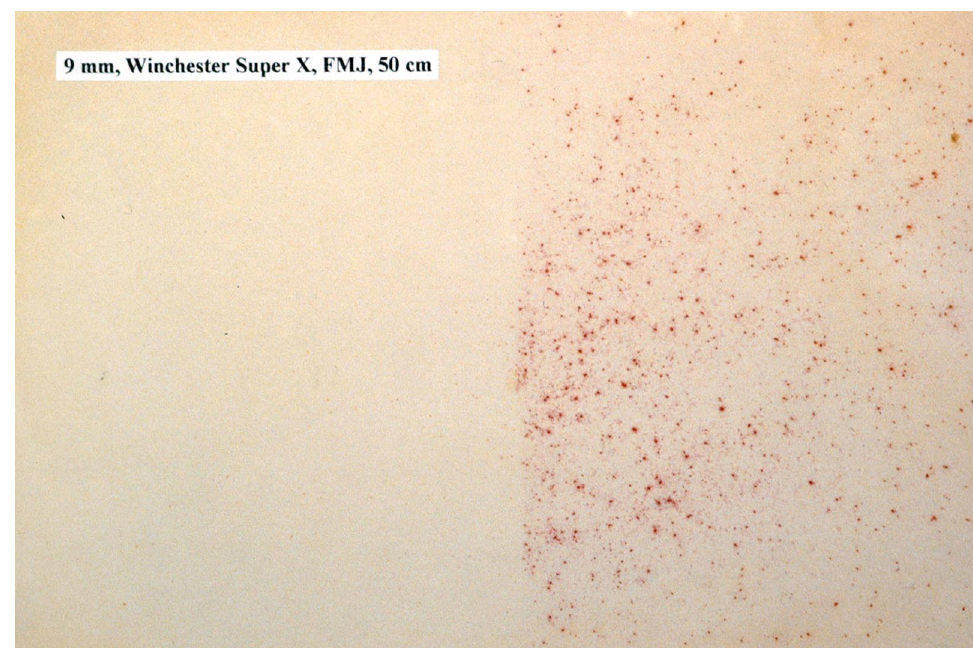
FIGURE 1 . A test shot on a white cotton cloth; ammunition 9-mm Winchester super-X FMJ, distance 50 cm. A color photograph of the target after application of MGT: (left) without the hydrolysis prior to MGT, (right) with the hydrolysis prior to